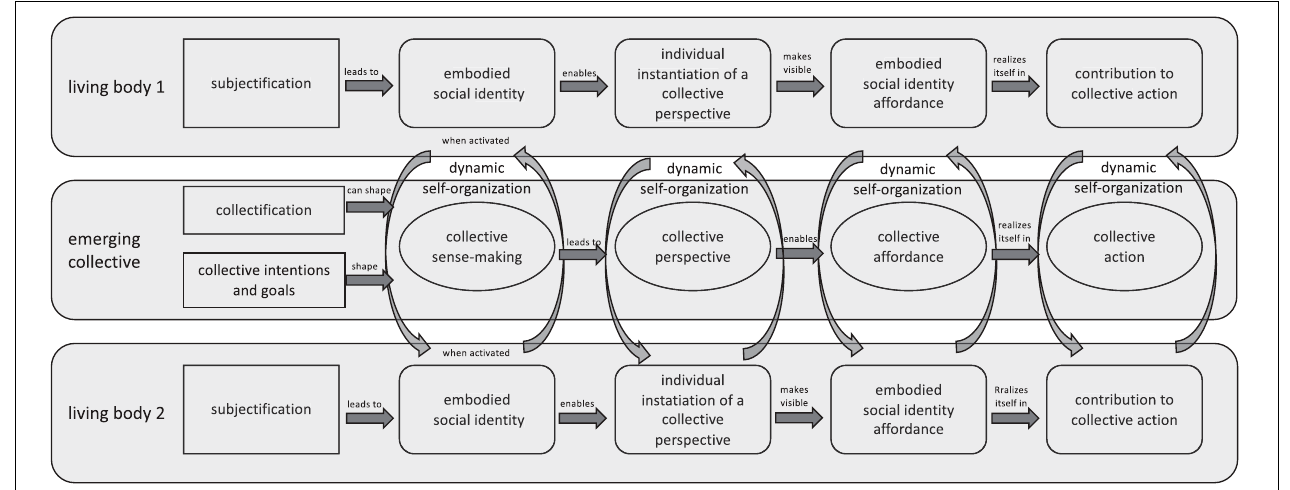
FIGURE 1 | Visual illustration of the proposed